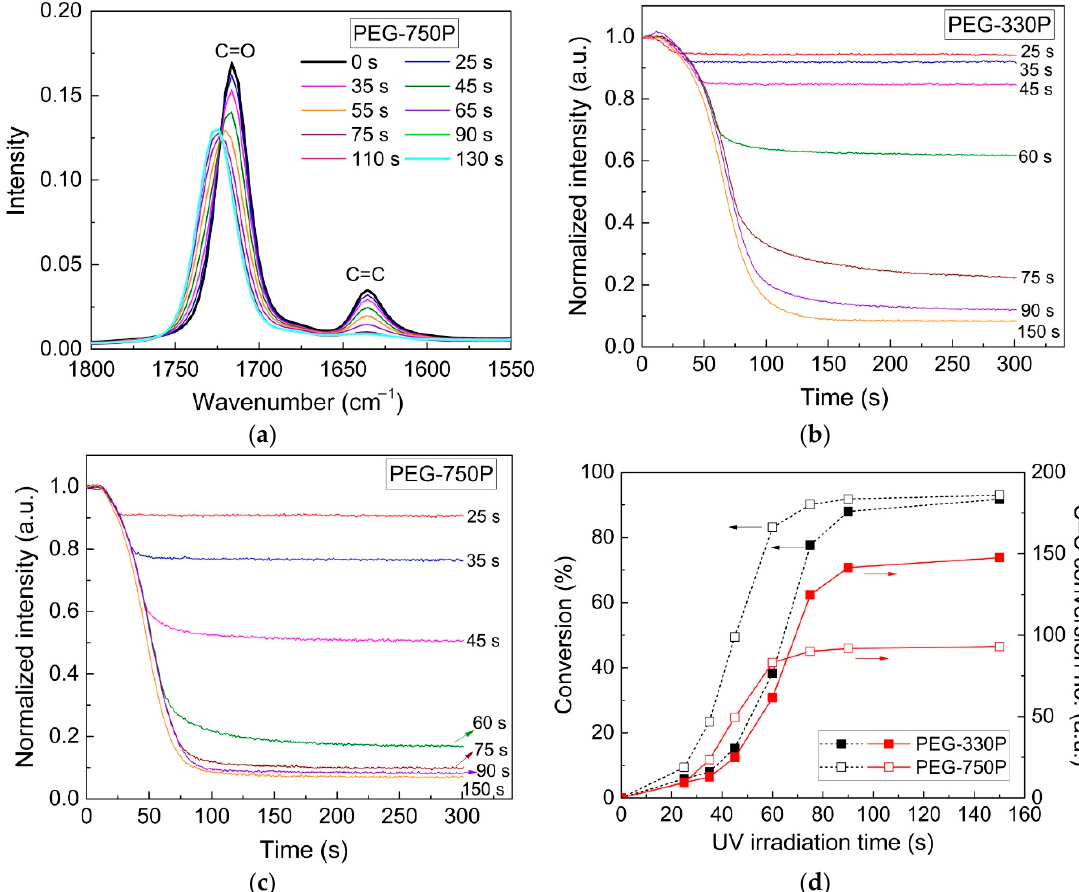
Figure 2. FT-IR intensity data for ( a ) a PEG-750P mixture and transient intensity changes of ( b ) PEG-330P and ( c ) PEG-750P mixtures during UV curing under different irradiation time conditions. ( d ) Changes in the conversion value and the actual number of C=C bonds participating in the reaction for the two cases.